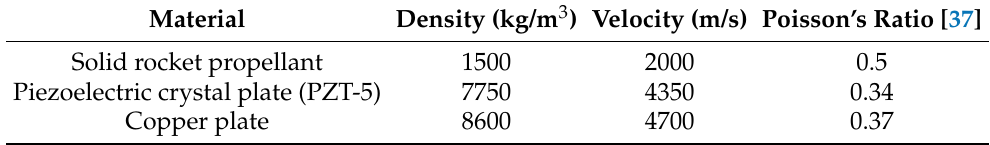
Figure 5. Simulation model of the four-laminated transducer (1. solid rocket propellants, 2. piezo- electric wafers, and 3. copper plate). Table 4. Parameters of key